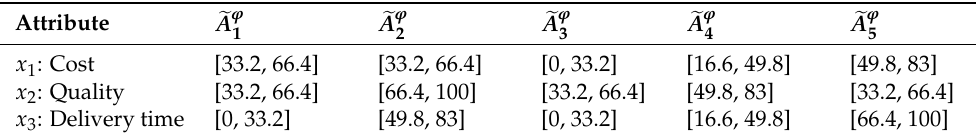
Table 3. Fuzzy sets for suppliers